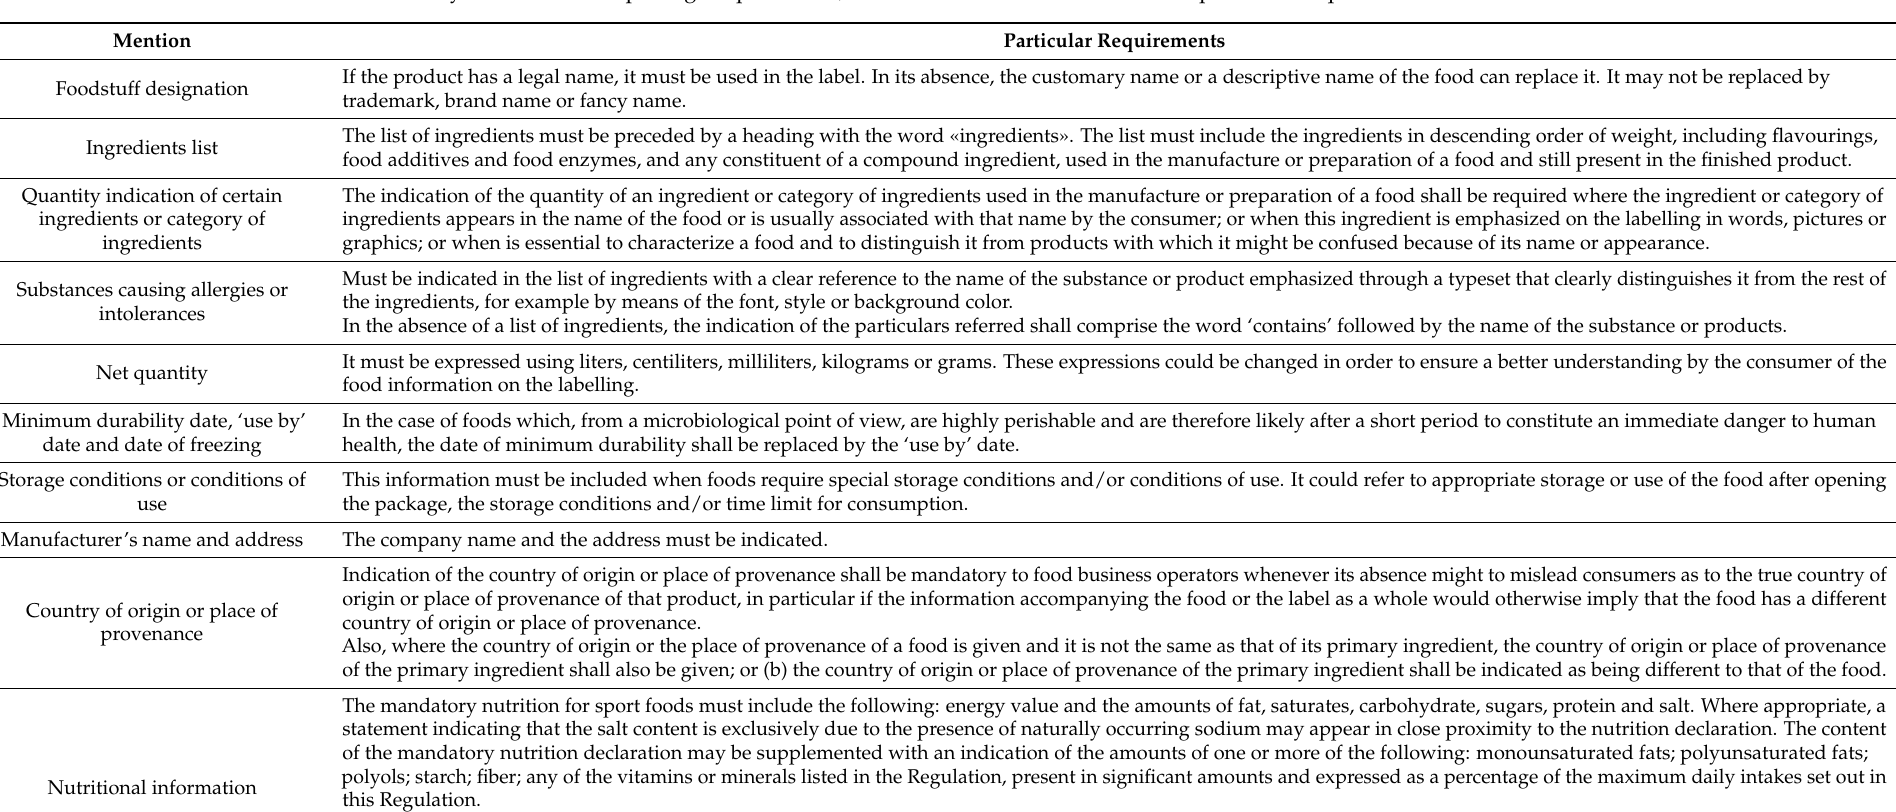
Table 1. Mandatory information for packaged sport foods, fortified or not. This table includes particular requirements for each